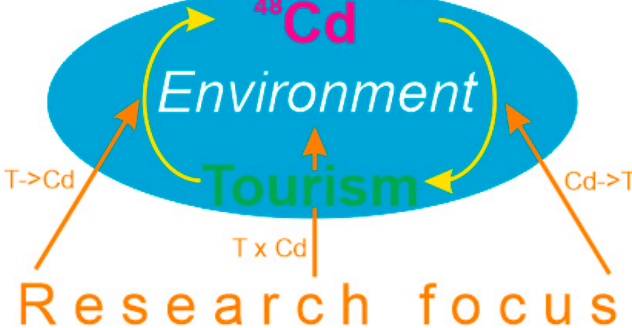
Figure 1. The three main subjects of research in the cadmium–tourism relationships.